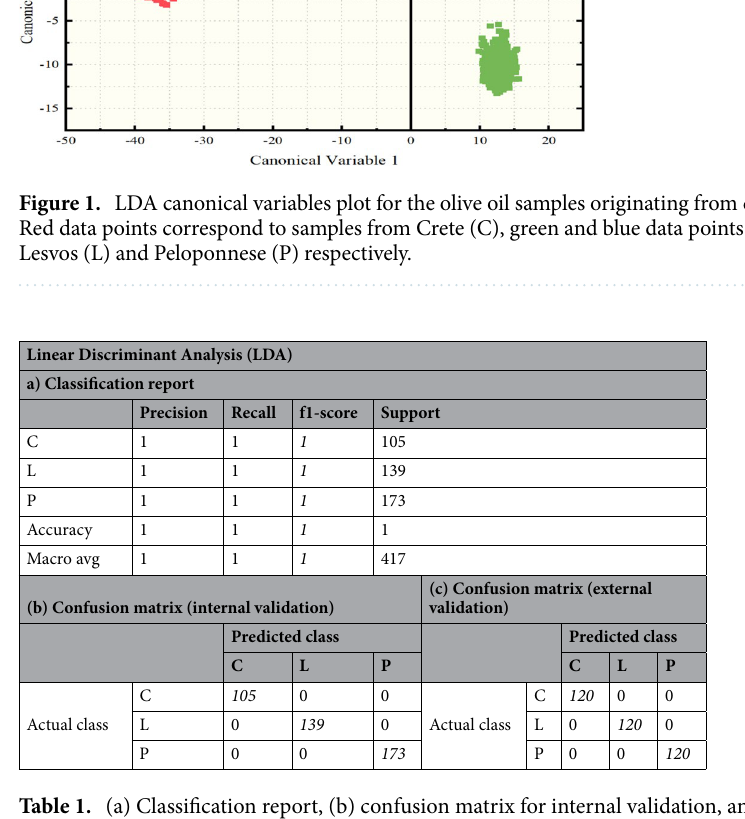
Table 1. (a) Classification report, (b) confusion matrix for internal validation, and (c) confusion matrix for external validation resulting from the LDA algorithm.